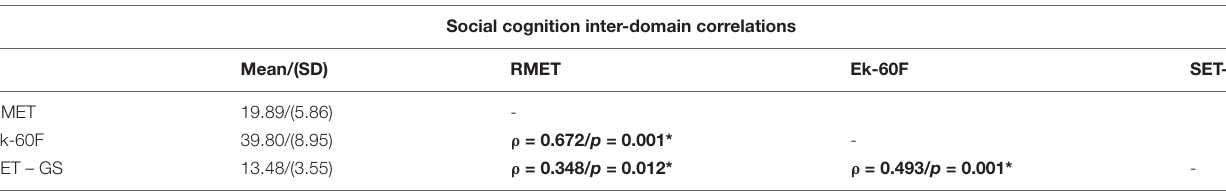
TABLE 2 | Non-parametric correlations among social cognition